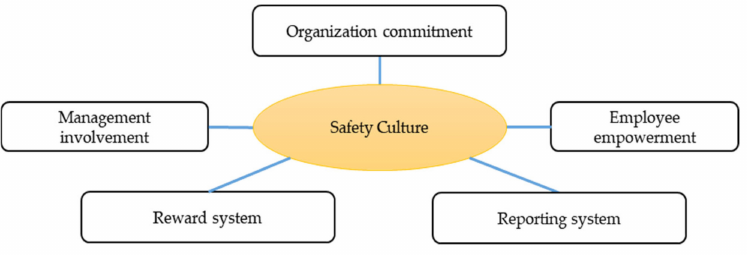
Figure 1. Safety culture indicators [12].